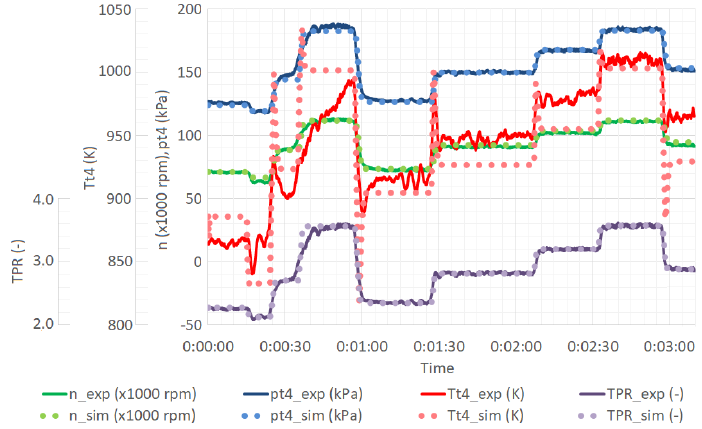
Figure 5. Comparison of experiment (exp) and simulated (sim)